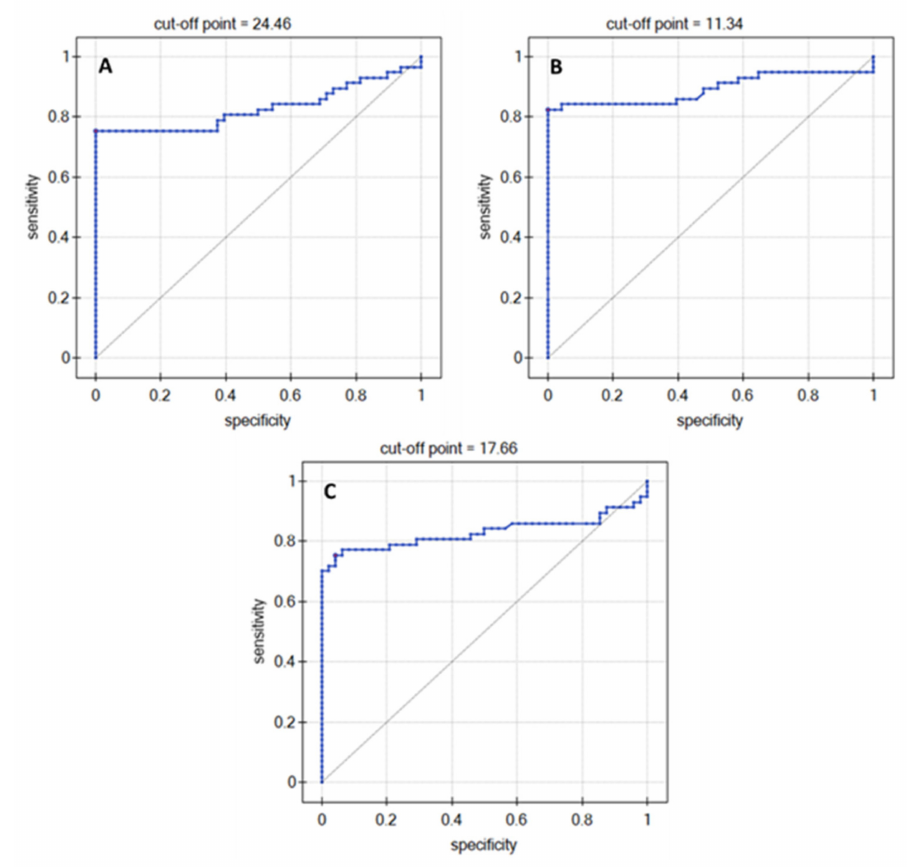
Figure 5. ROC curves: ( A ) MMP-1, ( B ) UCH-L1, and ( C ) 20S proteasome.